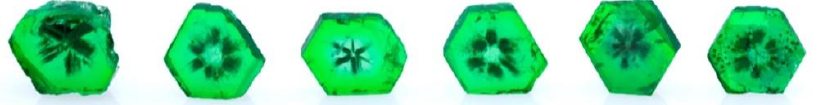
Figure 1. Six emerald wafers from Swat, Pakistan show a trapiche-like pattern weighing from 0.53 ct to 0.83 ct, with a thickness of around 1.51 to 2.08 mm. We have chosen the fourth sample from the left to study its inclusion further.